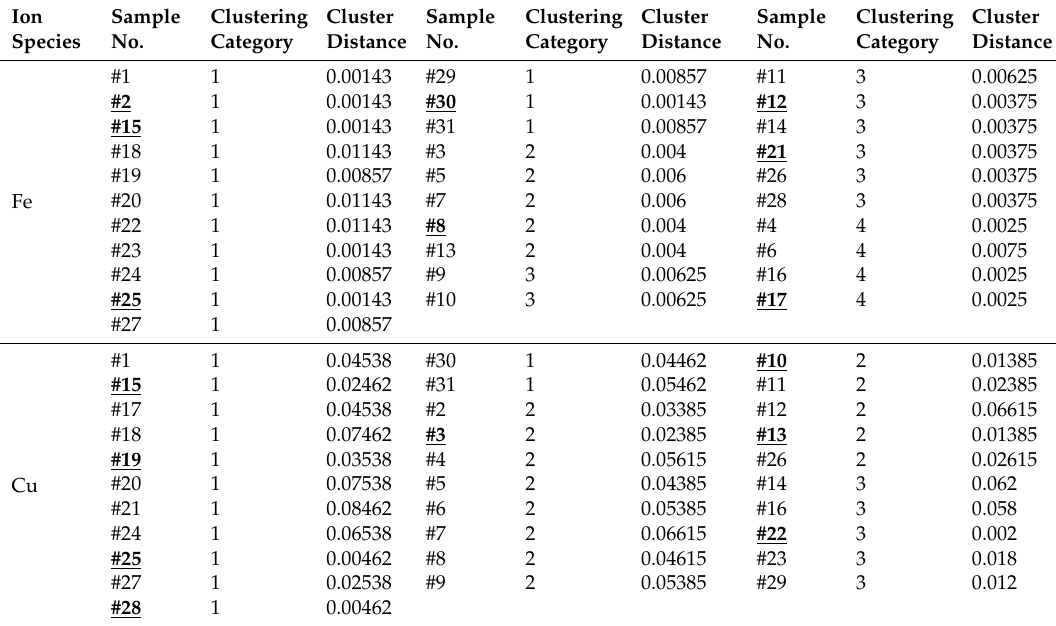
Table 1. The distance from Fe and Cu contents in each sample to the cluster centre.